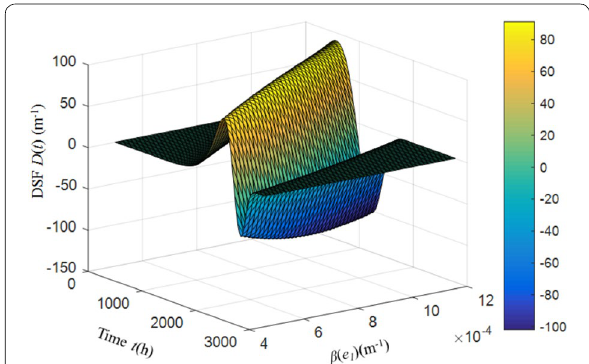
Figure 12 DSF curve of the belt drive system